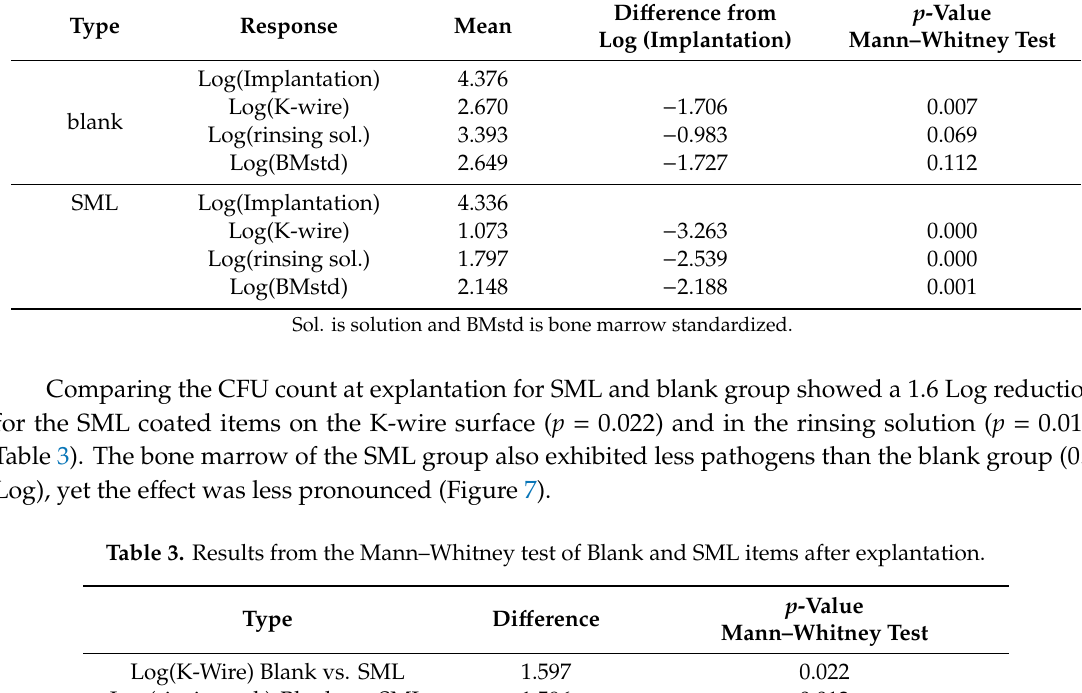
Table 2. Results from the Mann–Whitney test of Log (Implantation) compared to Log (Explantation).